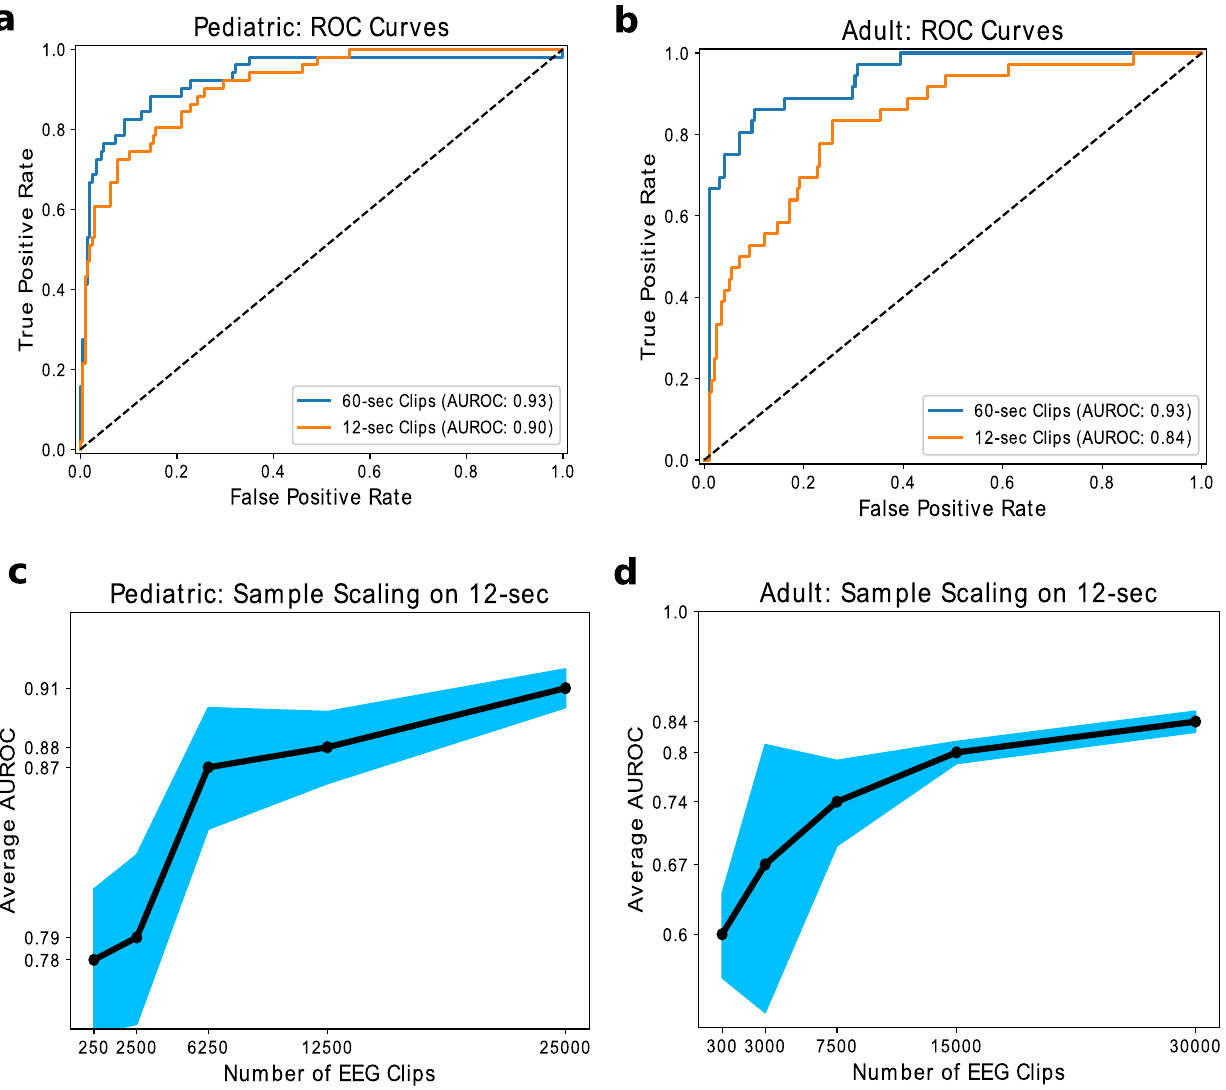
Fig. 3 ROC curves and sample scaling results. We plot a median ROC curves when evaluating our model trained on 25,386 weak labels over 60-s and 12-s EEG clips for pediatric patients and b median ROC curves when evaluating our model trained on 32,596 weak labels over 60-s and 12-s EEG clips for adult patients. We also show model performance versus the number of weak labels used for training over pediatric patients ( c ) and adult patients ( d ) over the 12-s EEG clips. Error bars represent 95% con fi dence intervals from fi ve training runs with different random